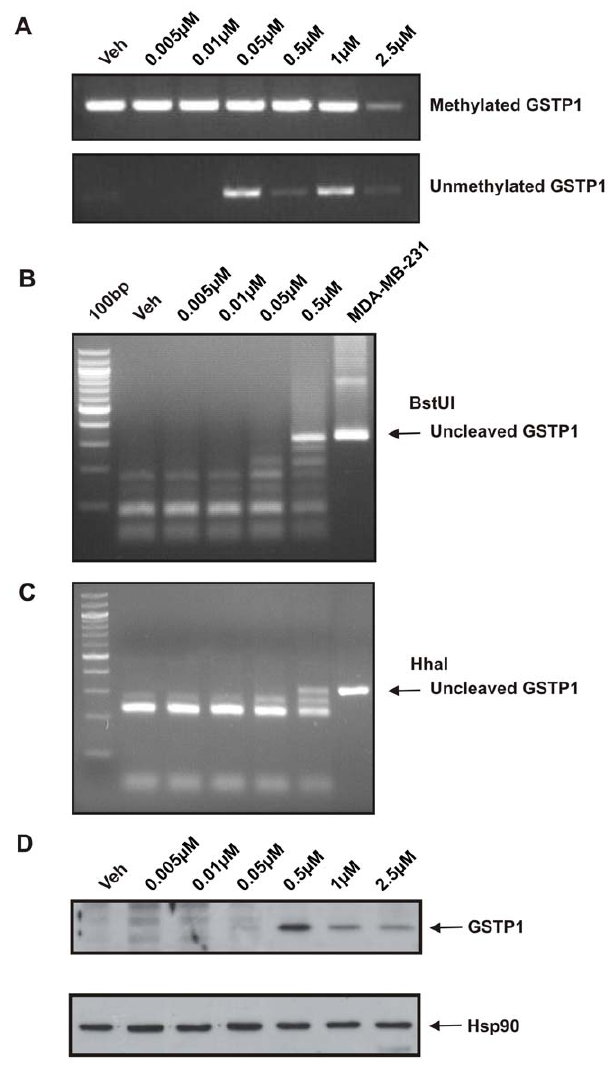
Figure 4. GSTP1 DNA methylation and protein expression in LNCaP cells after daily 5-aza-CdR treatment. DNA and proteins were extracted from LNCaP cells treated with increasing doses of 5-aza- CdR (0.005–2.5 m M). Cells were treated daily and DNA and protein harvested after 6 days of treatment. (A) MSP was performed on bisulfite-modified DNA with primers targeting bisulfite-modified methylated GSTP1 promoter or unmethylated GSTP1 promoter. (B–C) the relative methylation status of the GSTP1 promoter following 5-aza- CdR treatment was further assessed by COBRA using two restriction enzymes, BstUI and HhaI. MDA-MB-231 breast cancer cells were used as a control for unmethylated GSTP1 promoter. (D) Immunoblot was performed to analyze GSTP1 protein expression. Detection of Hsp90 was used as a loading control.